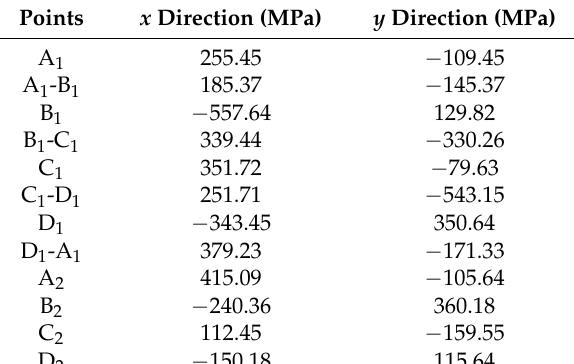
Table 2. Stress in plastic-deformed area of specimen 2#.